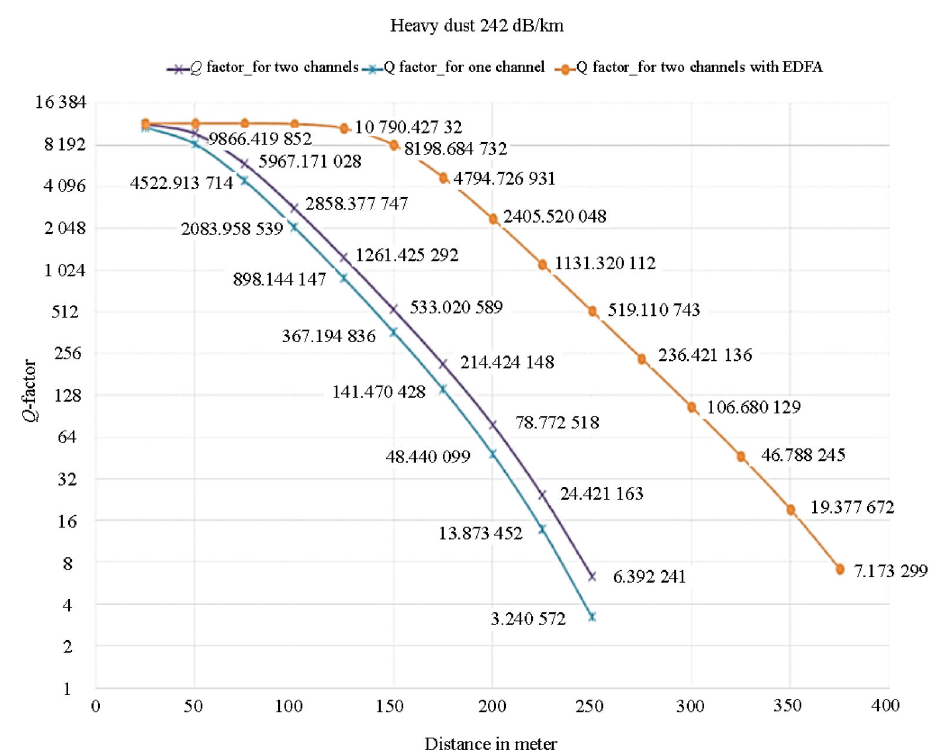
Fig. 9 Quality factor at 242 dB/km according to the distance.